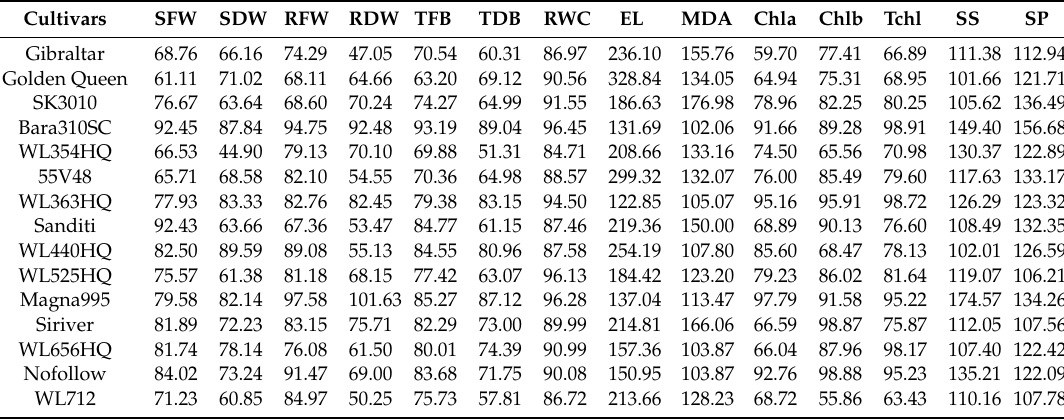
Table 3. Heat tolerance coe ffi cients of biomass and physiological traits (indexes) of alfalfa cultivars.